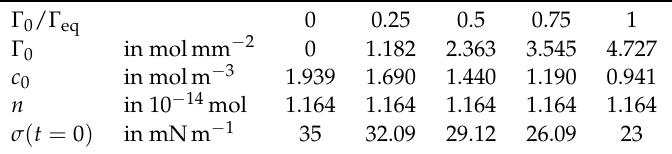
Table 1. Surface tension and surfactant concentrations for different initial surfactant distributions.